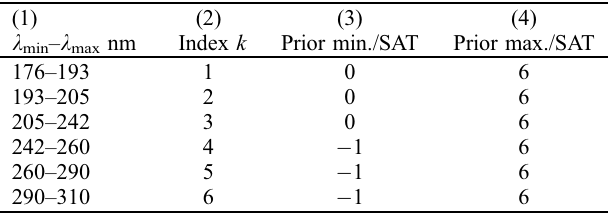
Table 3. The minimum and maximum allowed values of the priors, in multiples of SATIRE-S SC changes, are given in columns 3 and 4, respectively, for each of the wavelength bands and their indices given in columns 1 and 2,